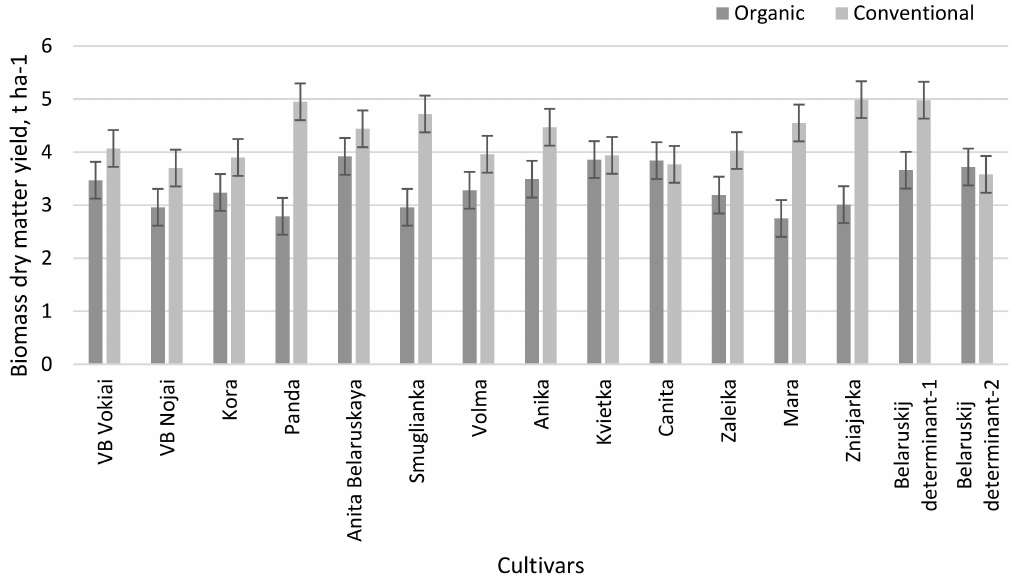
Figure 1. Biomass yield of buckwheat cultivars in different farming systems (LSD 05(AxB) = 0.347).